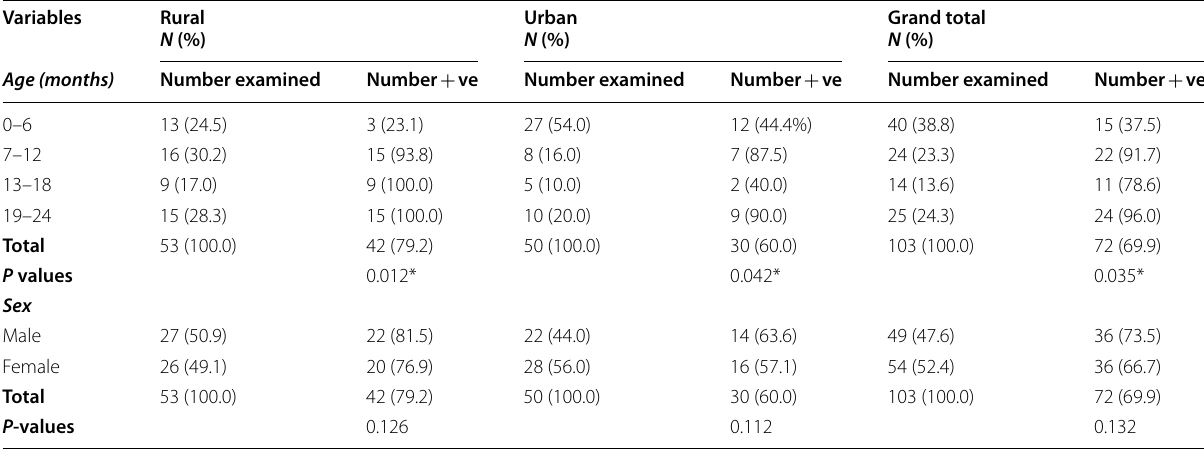
Values asterisk (*) connotes significant difference in a column